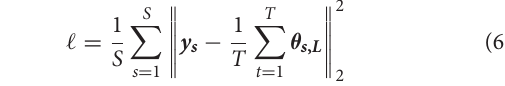
FIGURE 2 | Left: 48-chip SpiNNaker 103 board. Center: View of a single chip, consisting of 18 cores, a shared RAM and a Network-On-Chip router. Right: View of a single core, consisting of a tightly-coupled memory and an ARM processor. a densely connected layer of SNNs with a size equal to the number of classes (10 for N-MNIST). The objective is to maximize the firing rate of the neuron corresponding to the desired output. This is achieved by training the readout layer using the Spatio Temporal Back Propagation (STBP) (Wu et al., 2018) algorithm, a time-dependent generalization of the ANN’s backpropagation algorithm. The loss function ℓ across S training samples and a time window T is defined